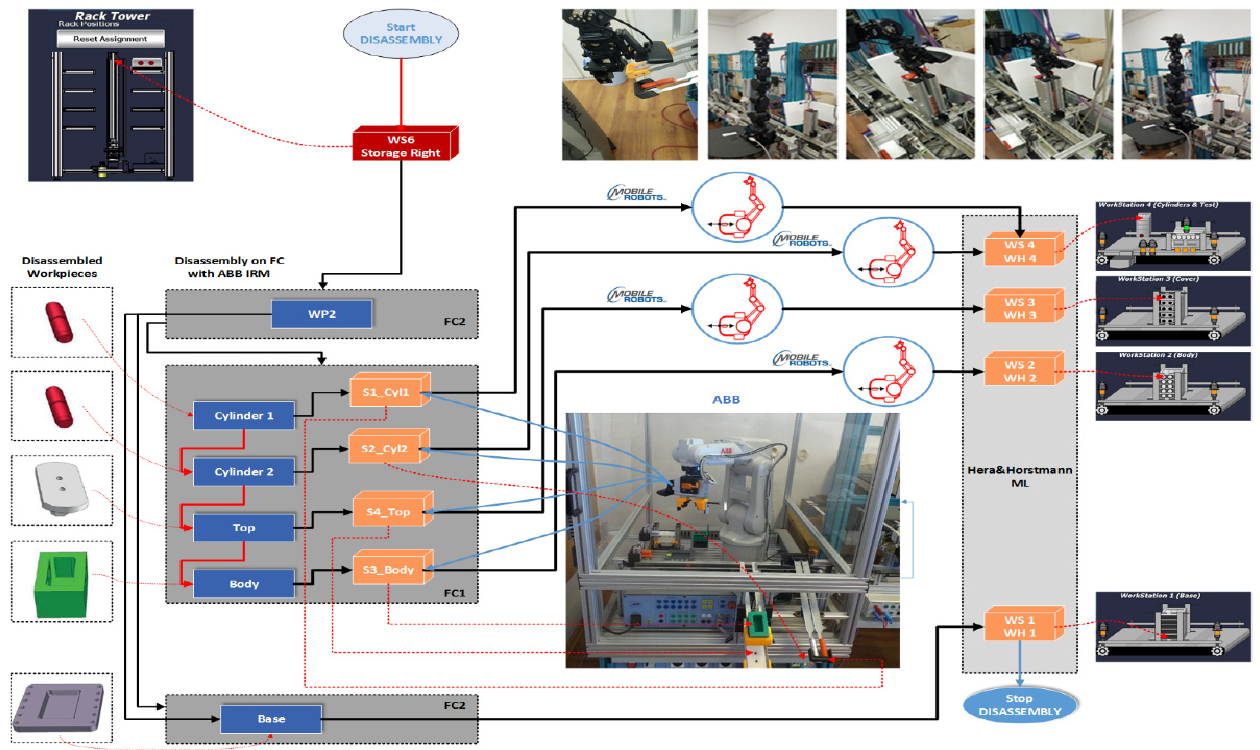
Figure 10. Disassembly task planning.